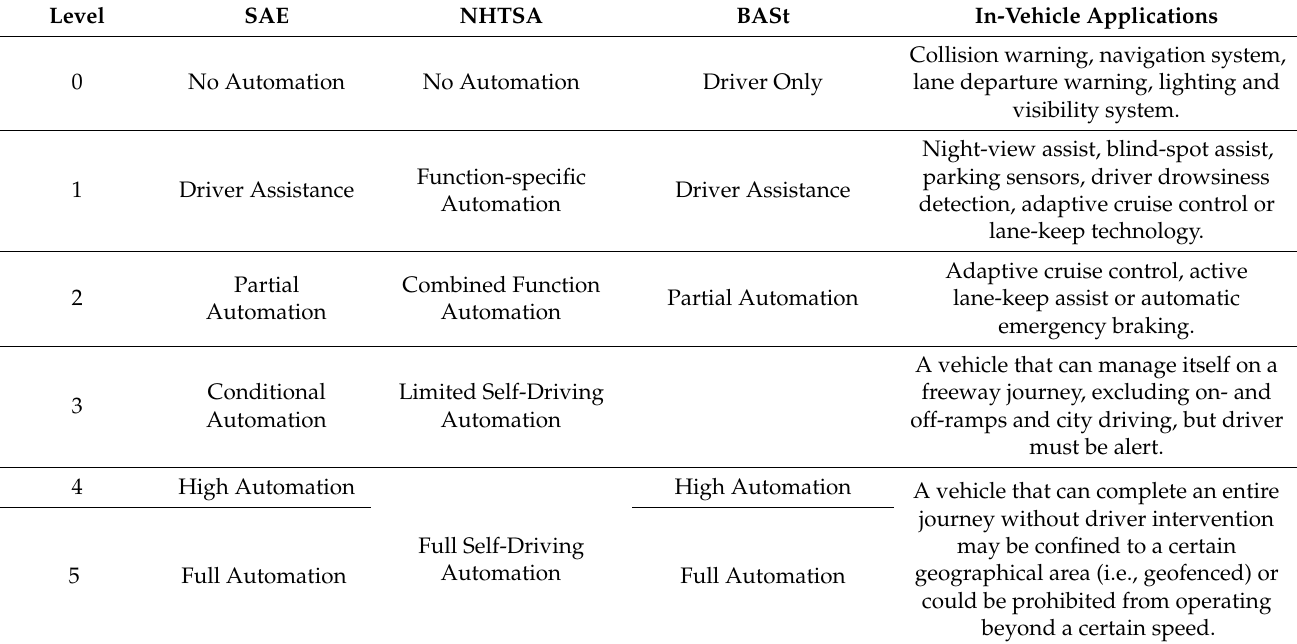
Table 3. In-vehicle technology applications based on driving automation standards.